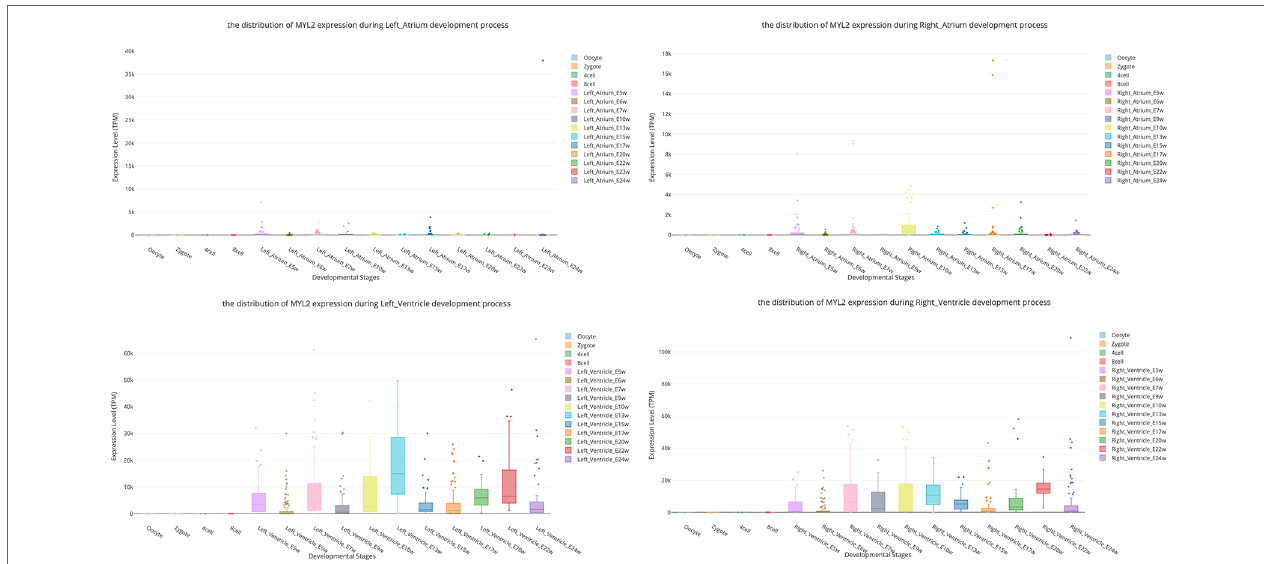
FIGURE 5 | Comparison of MYL2 expression distributions between atrium cell types and ventricle cell types.